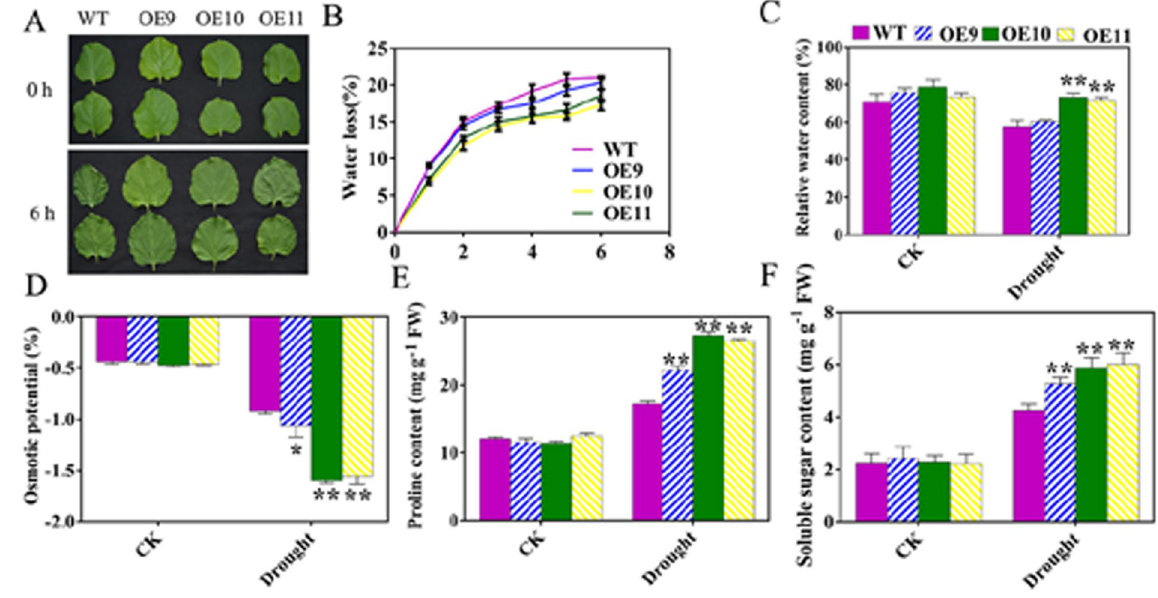
Figure 4. Influence of drought stress on water loss, relative water content, osmotic potential, proline content, and soluble sugar content in the OE and WT plants. The phenotypes and kinetics of water loss from the leaves of 2-month-old N . benthamiana lines ( A , B ). ( C ) Relative water content. Blades separated from 2-month-old TaPUB1 -overexpressing and WT lines after drought treatment. ( D ) Osmotic potential. ( E ) Proline content and ( F ) Soluble sugar content after drought treatment. The experiments were repeated three times and the bars indicate SEs. * and ** indicate significant differences at P < 0.05 and P < 0.01 among the three overexpression lines and the WT